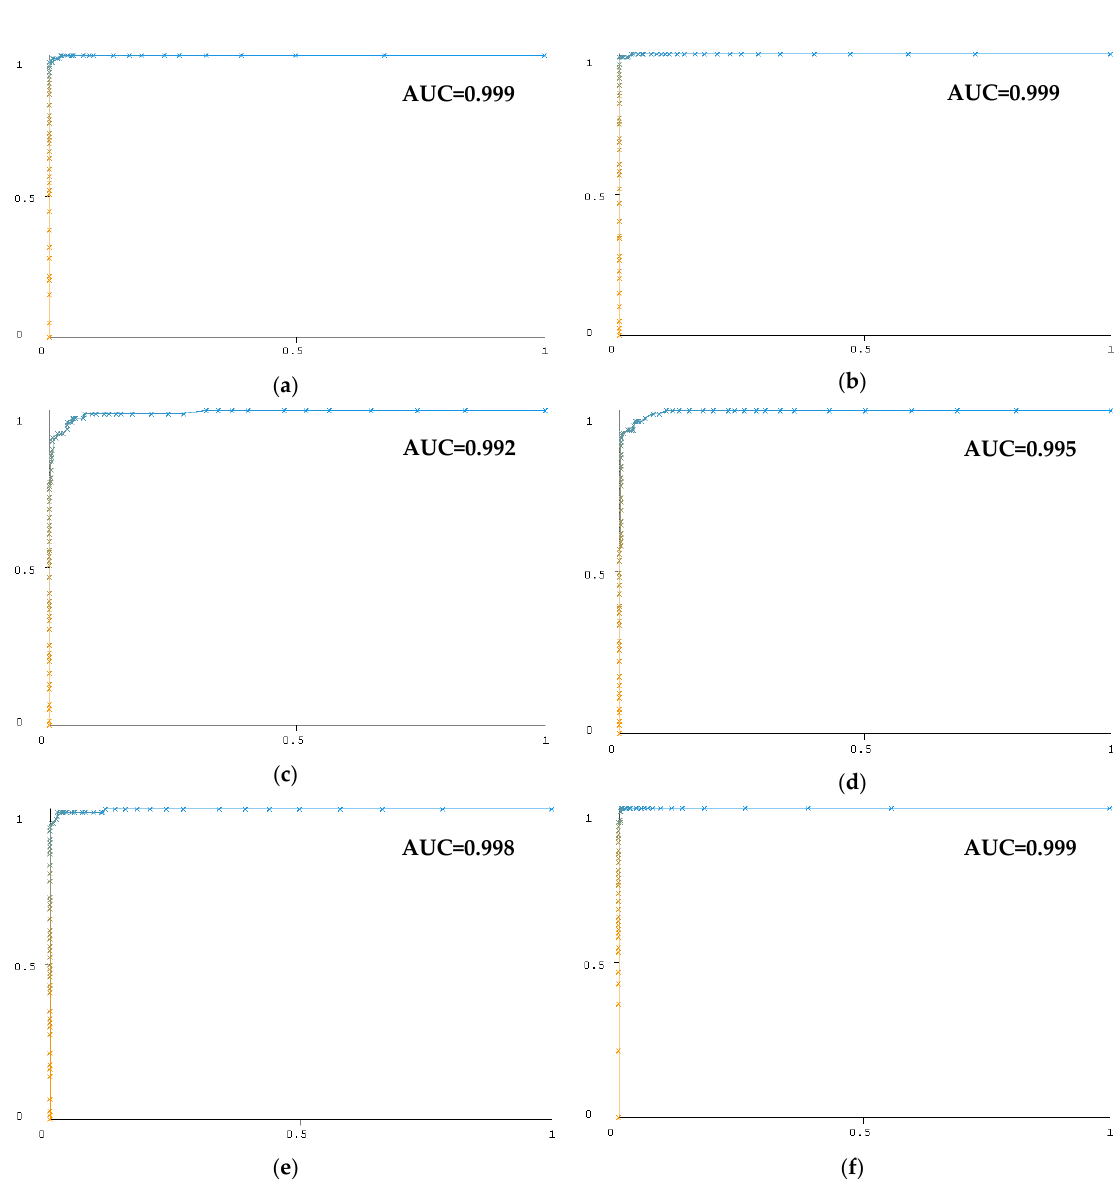
Figure 11. ROC curves for classi fi cation of balanced data with Random Forest. ( a ) GCS3 class, ( b ) GCS4 class, ( c ) GCS5 class, ( d ) GCS6 class, ( e ) GCS7 class, and ( f ) GCS8 class.